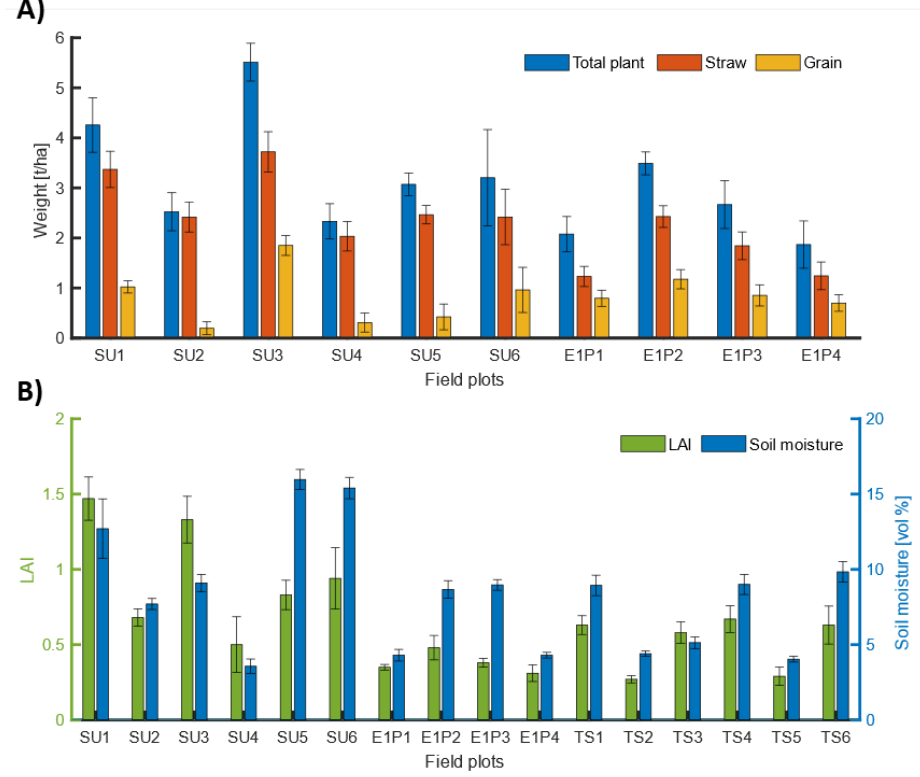
Figure 6. Field measurements at agricultural field plots: ( A ) Crop (dry) biomass weight separately for total plant, straw, and grain, ( B ) LAI and soil moisture. Table 3. Summary statistics of field data collected at test sites SU, E1, and TS. Table 3. Summary statistics of field data collected at test sites SU, E1, and